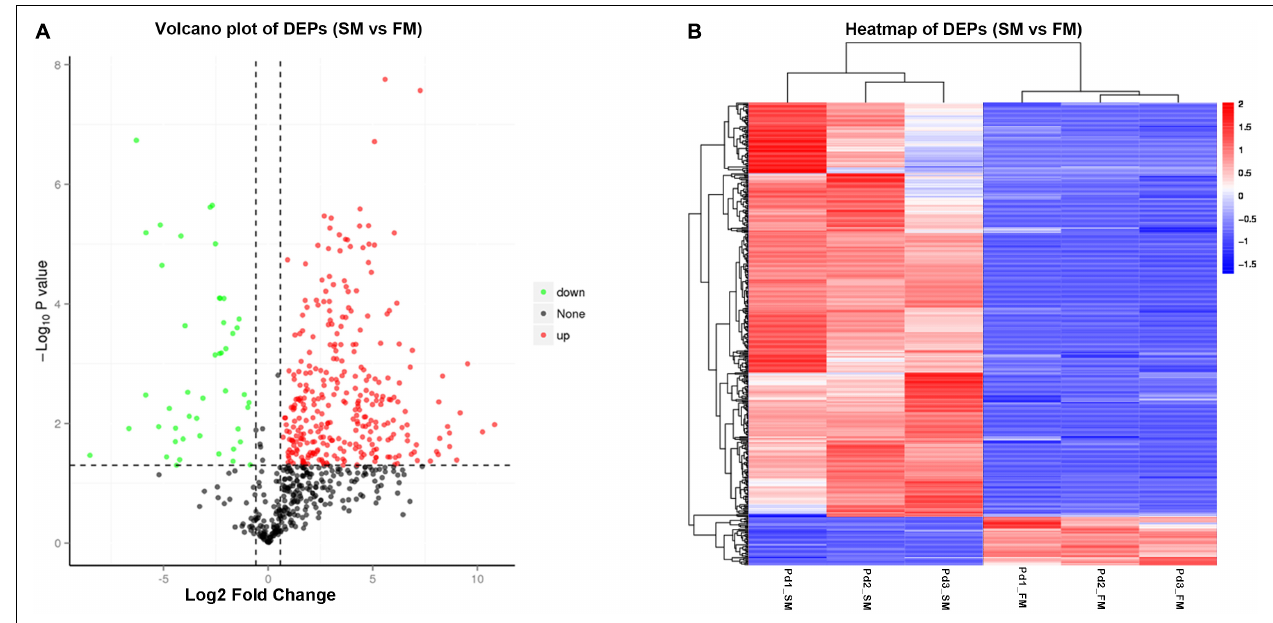
FIGURE 3 | Differentially expressed proteins (DEPs) between slow-twitch muscle and fast-twitch muscle in P. dentex . (A) Volcano plot of DEPs. Red dots represent proteins with significantly higher expression levels in slow-twitch muscle, while green dots represent proteins with significantly higher expression levels in fast-twitch muscle (fold change ≥ 1.5 and p < 0.05). (B) Hierarchical cluster heatmap of DEPs. Red represents upregulated proteins, while blue represents downregulated proteins. The color intensity changes with the protein abundance, as commented in the key bar on the upper right. Pd1, Pd2, and Pd3, the three